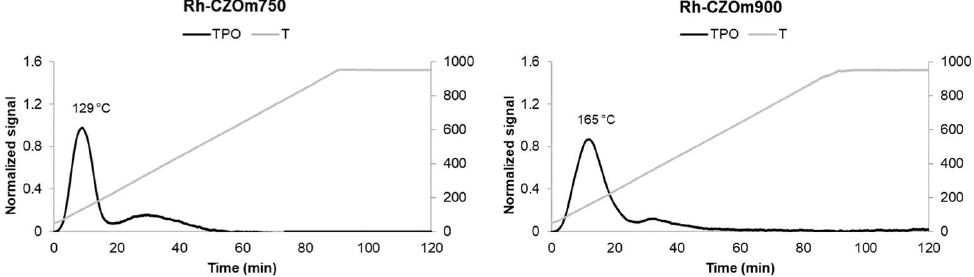
Figure 5. Temperature-programmed oxidation of Rh-CZOm750 and CZOm900